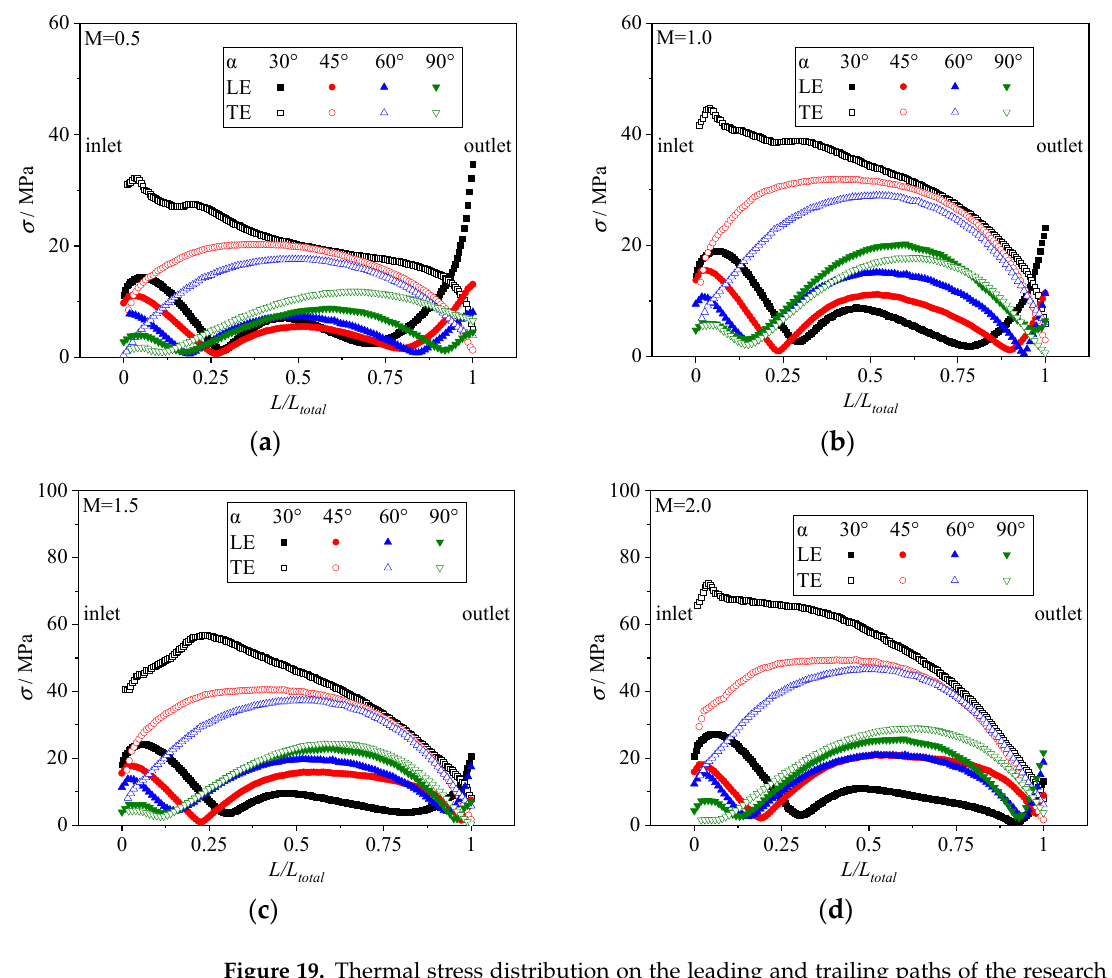
Figure 18. Contours of thermal stress at Y = 0 plane near the research film hole.